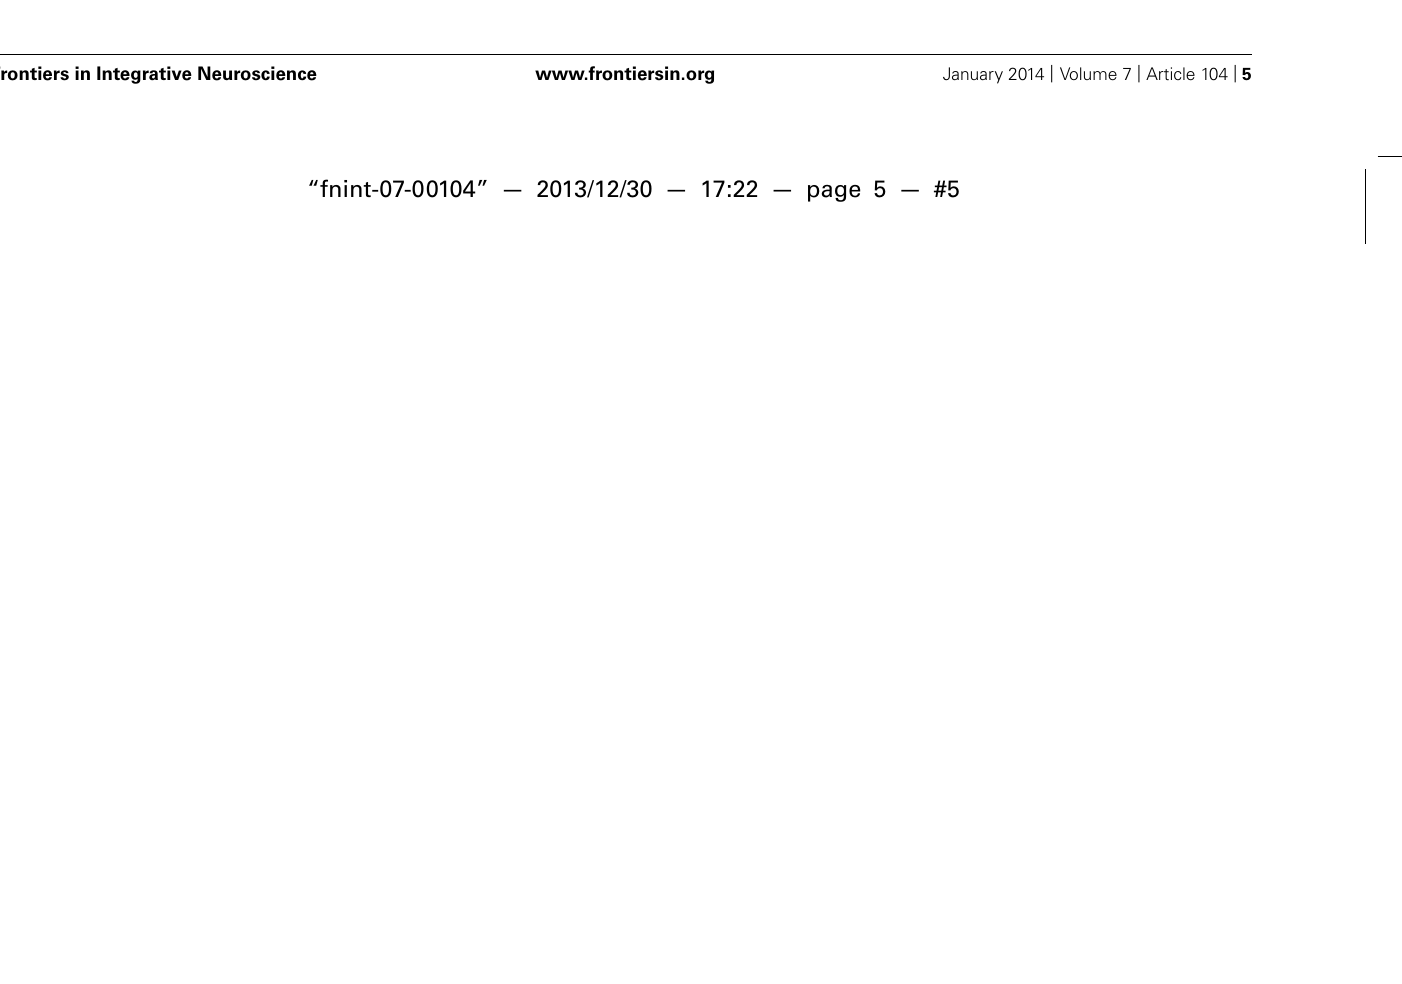
isopotential map that shows that the seizure began within the cortex and propagated to the basal ganglia and thalamus. (F) Typical traces were selected and magnified. Notice that the duration and amplitude of epileptiform activity were larger on the right side of the ACC (i.e., thalamic input removal side). (G) Summary results that show that the amplitude and duration of epileptiform activity were significantly larger in the thalamic removal groups. However, when the concentration was increased to 50 μ M to completely block GAB- Aergic transmission, no significant difference was observed between groups. Comparison were performed using ANOVA and post hoc t -test (** p < 0.01). Caud, caudate; Cx, cortex;Th, thalamus. Adapted from Chang etal.